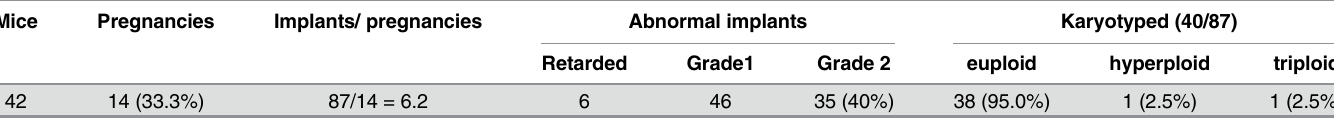
Table 2. Karyotypes of retarded/resorbed fetuses in 17-month-old C57BL/6 mice.